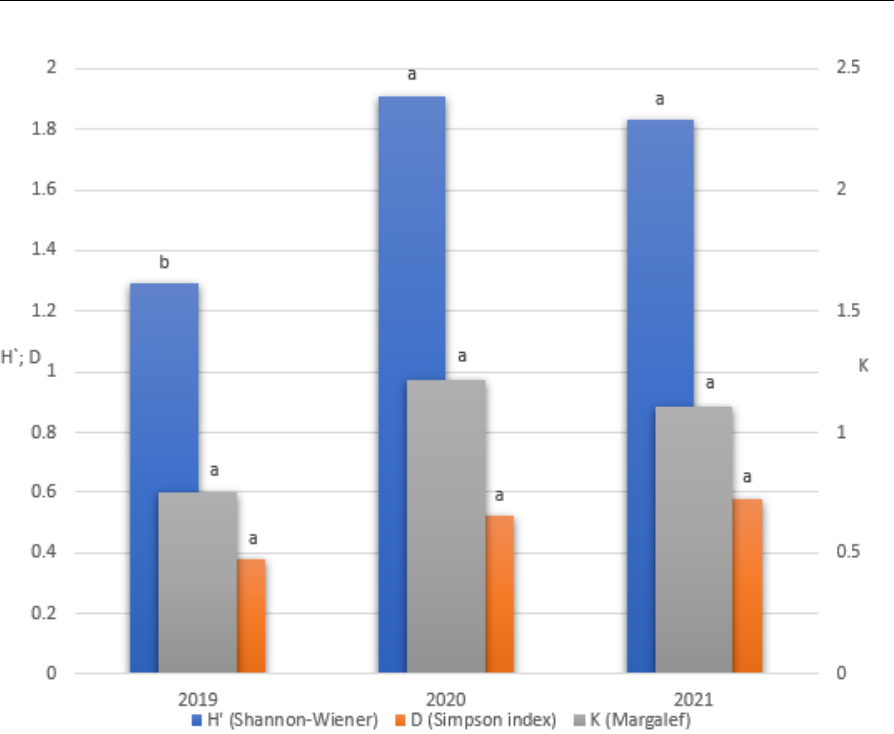
Figure 1. Shannon − Wiener (H’), Simpson’s (D) indexes of weed diversity, and Margalef’s richness index in maize. The same letters indicate that treatments were not significantly different according to the Tukey test.